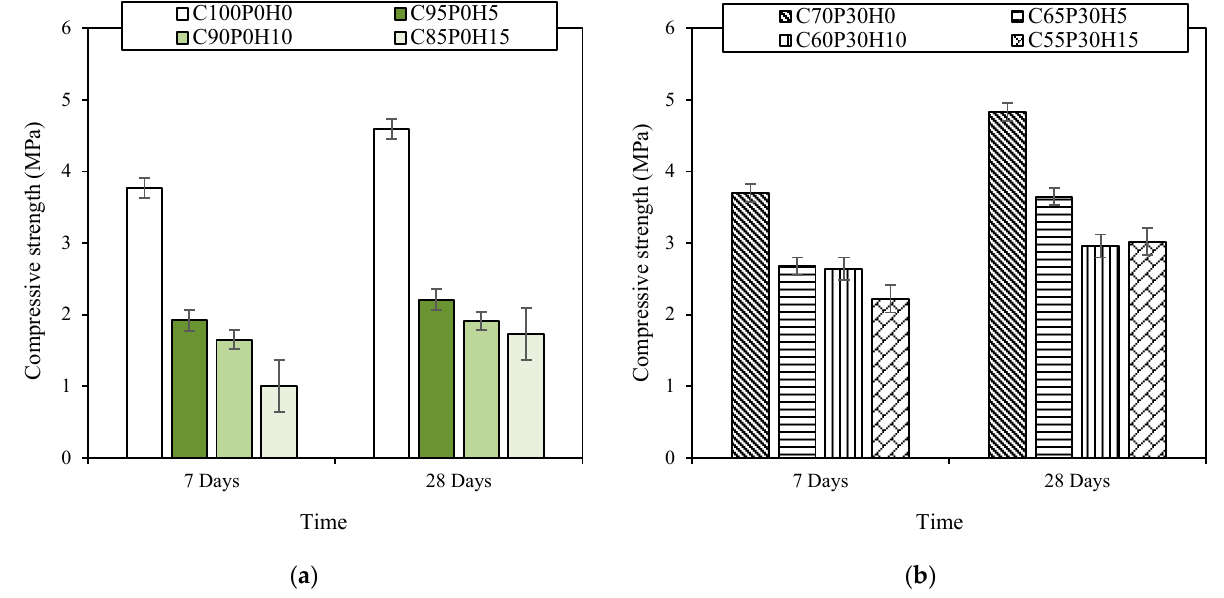
Figure 3. Compressive strength against time for ( a ) C100-BFCs and ( b ) C70-BFCs. Page et al. [34] remarked that the addition of a superplasticiser improves the interface